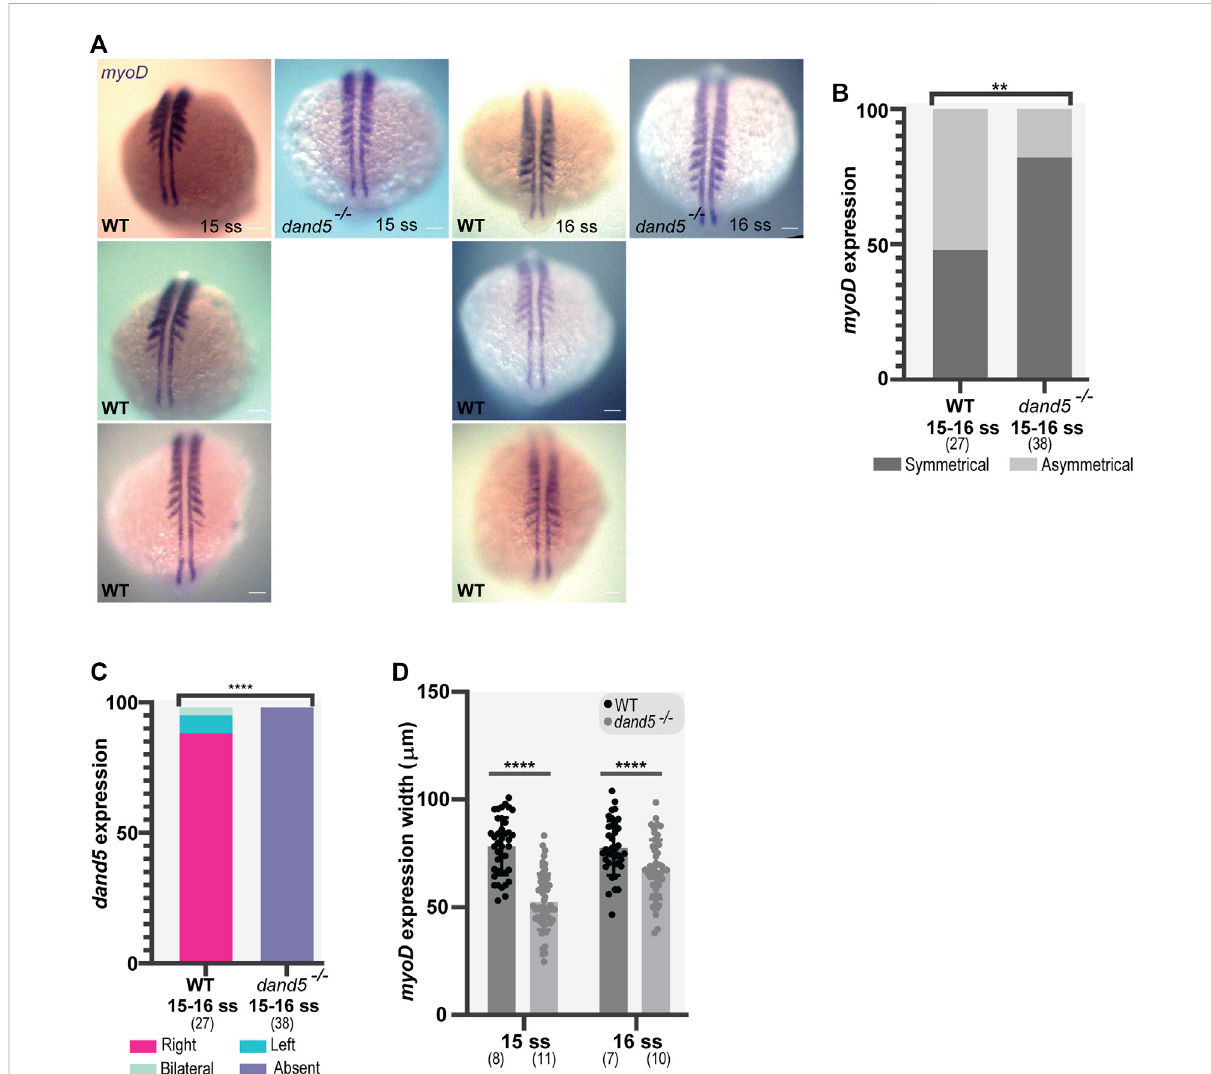
FIGURE 7 Whole-mount insitu hybridizationfor myoD and dand5 expression. (A,B) myoD expressionandsidescoring. (C) Quanti fi cationofdifferencesin dand5 expression patterns in WT vs dand5 homozygous mutants. The chi-squared test was used for statistical analysis. (D) Quanti fi cation of myoD widthinWT and dand5 − / − at15and16 ssembryos. t -testunpairedcomparison.Barsrepresent meanvalues,and dotsrepresent individual embryos.* correspondstoa p -value < 005;**toa p -value < 0.005;***toa p -value < 0.0005and****toa p -value < 0.00005.Scalebar=100 µm.Thetopis anterior, and the bottom is posterior. N is shown in